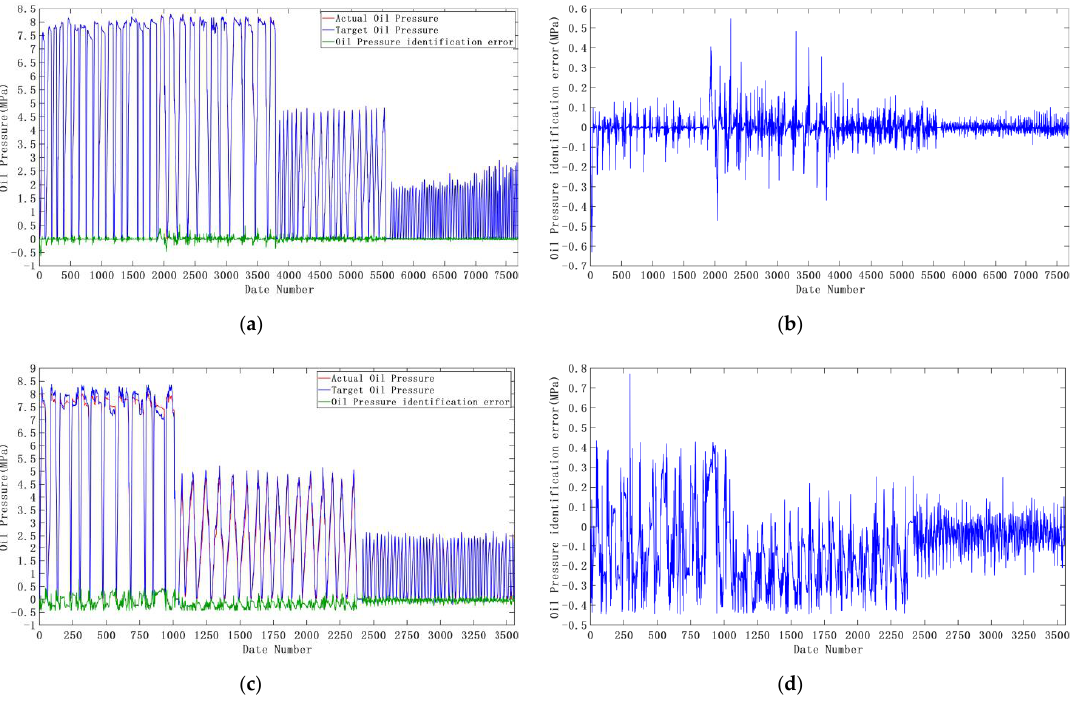
Figure 16. Oil pressure recognition results of the training set and testing set under general braking conditions: ( a ) Actual oil pressure, target oil pressure and oil pressure identification error of training set. ( b ) Oil pressure identification error of training set. ( c ) Actual oil pressure, target oil pressure and oil pressure identification error of testing set. ( d ) Oil pressure identification error of testing set.